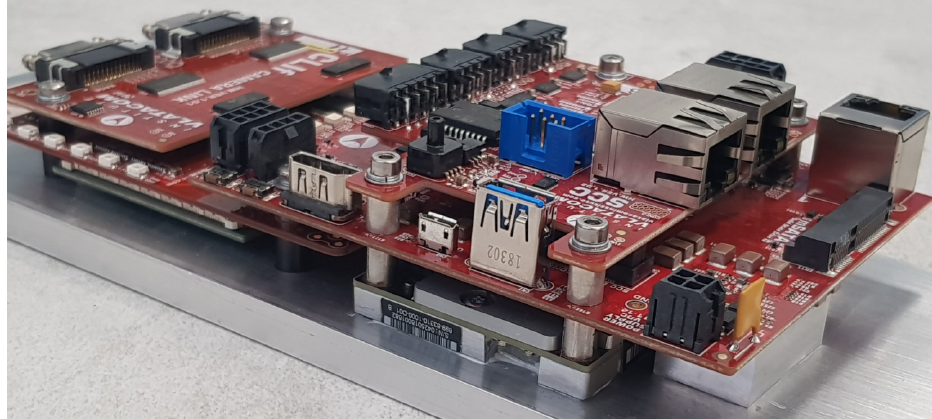
Figure 15. VVSP fanless solution .